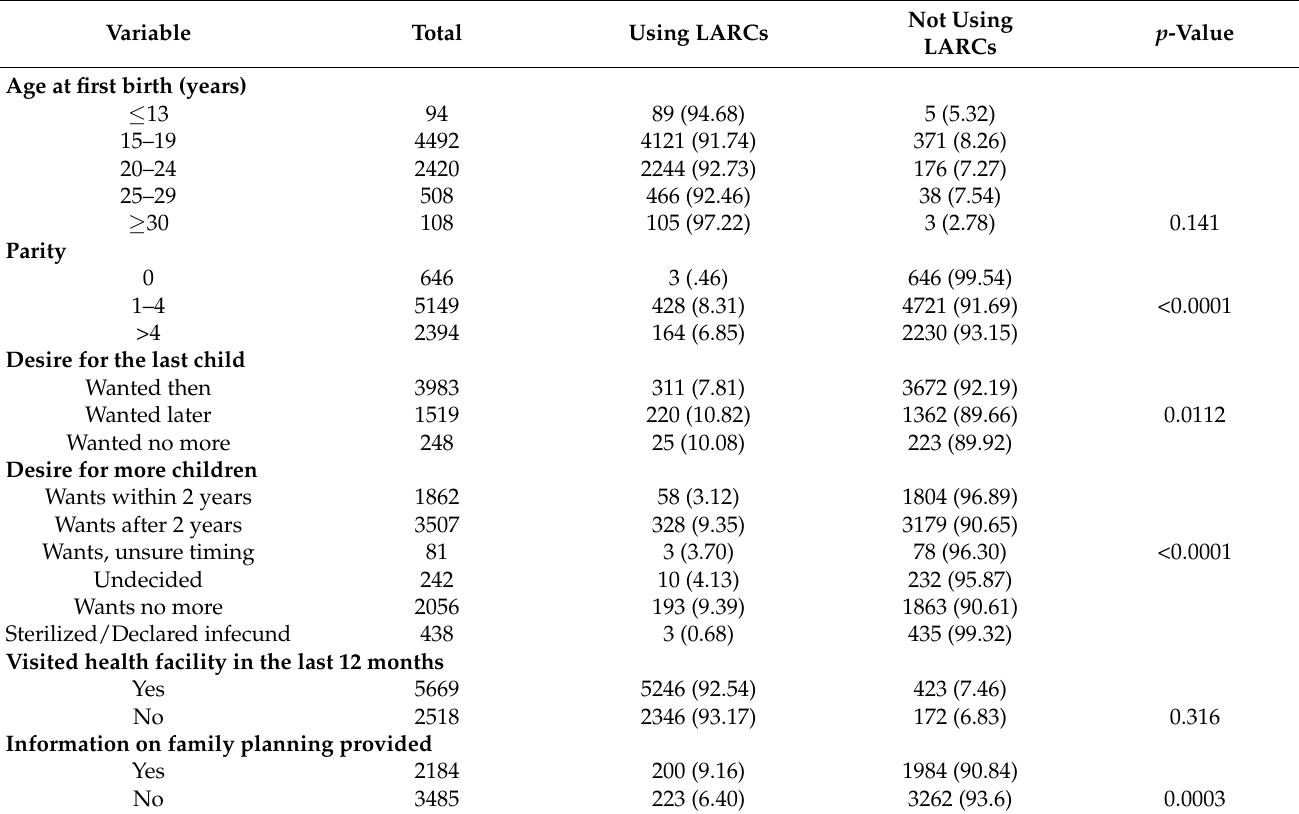
Table 2. Obstetric characteristics of participants related to long-acting family planning utilization (N =